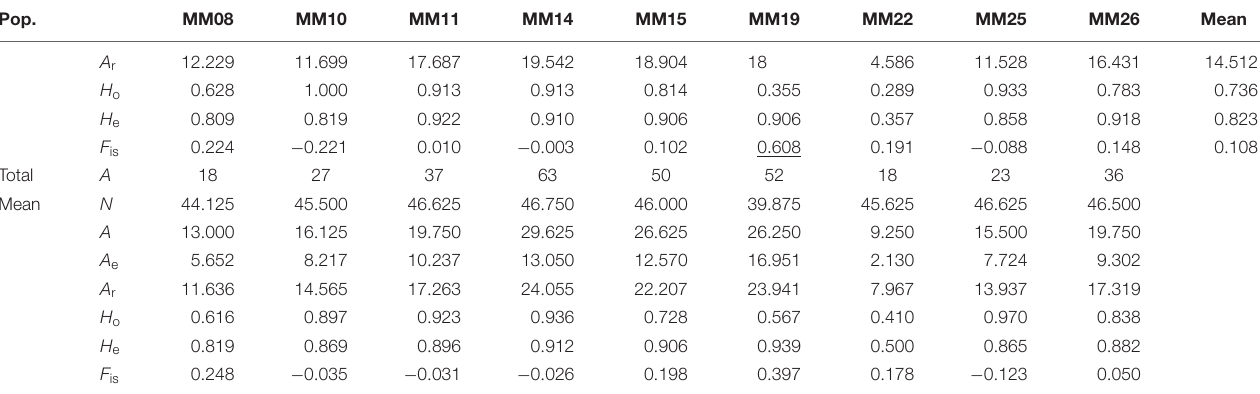
remarkable differentiation between YS samples and SCS samples.